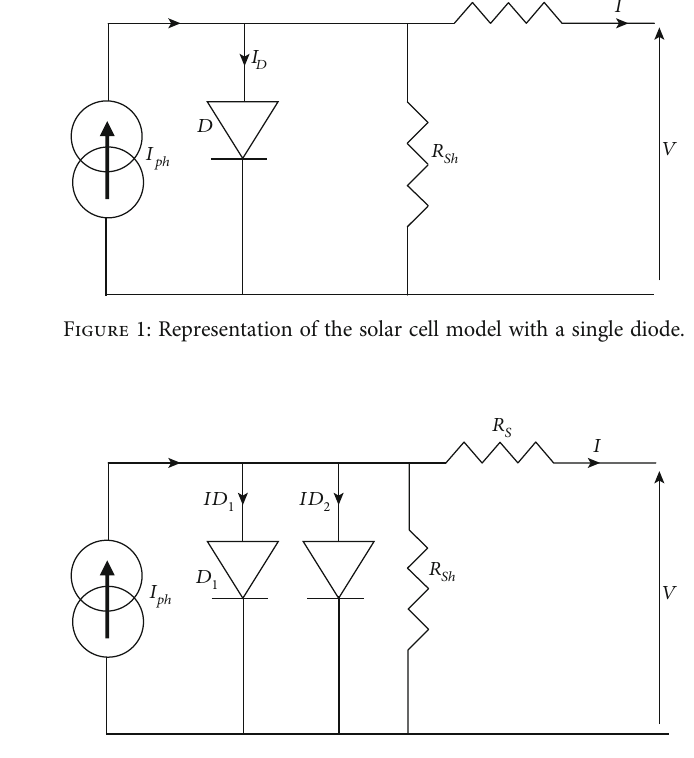
Figure 2: Representation of the solar cell model with double